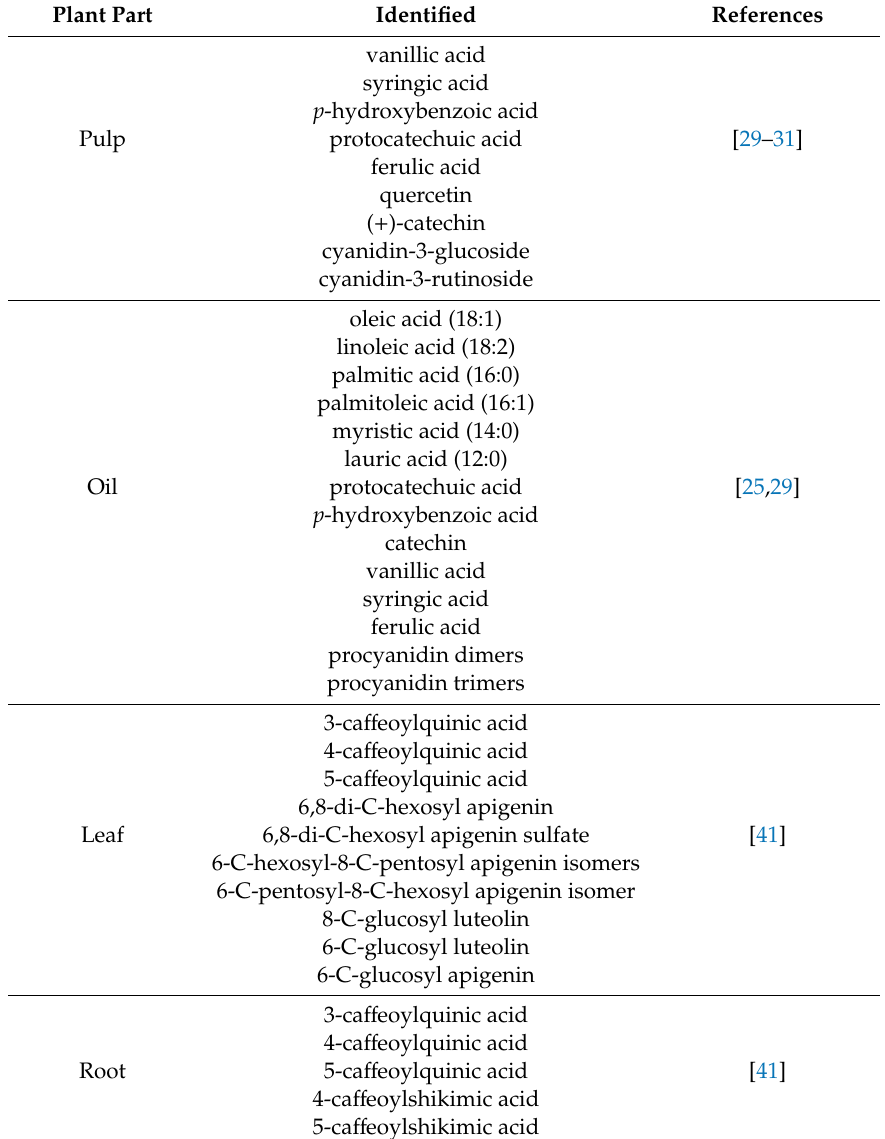
Table 1. Chemical profile of di ff erent parts of Euterpe oleracea Mart. with pharmacological application. Plant